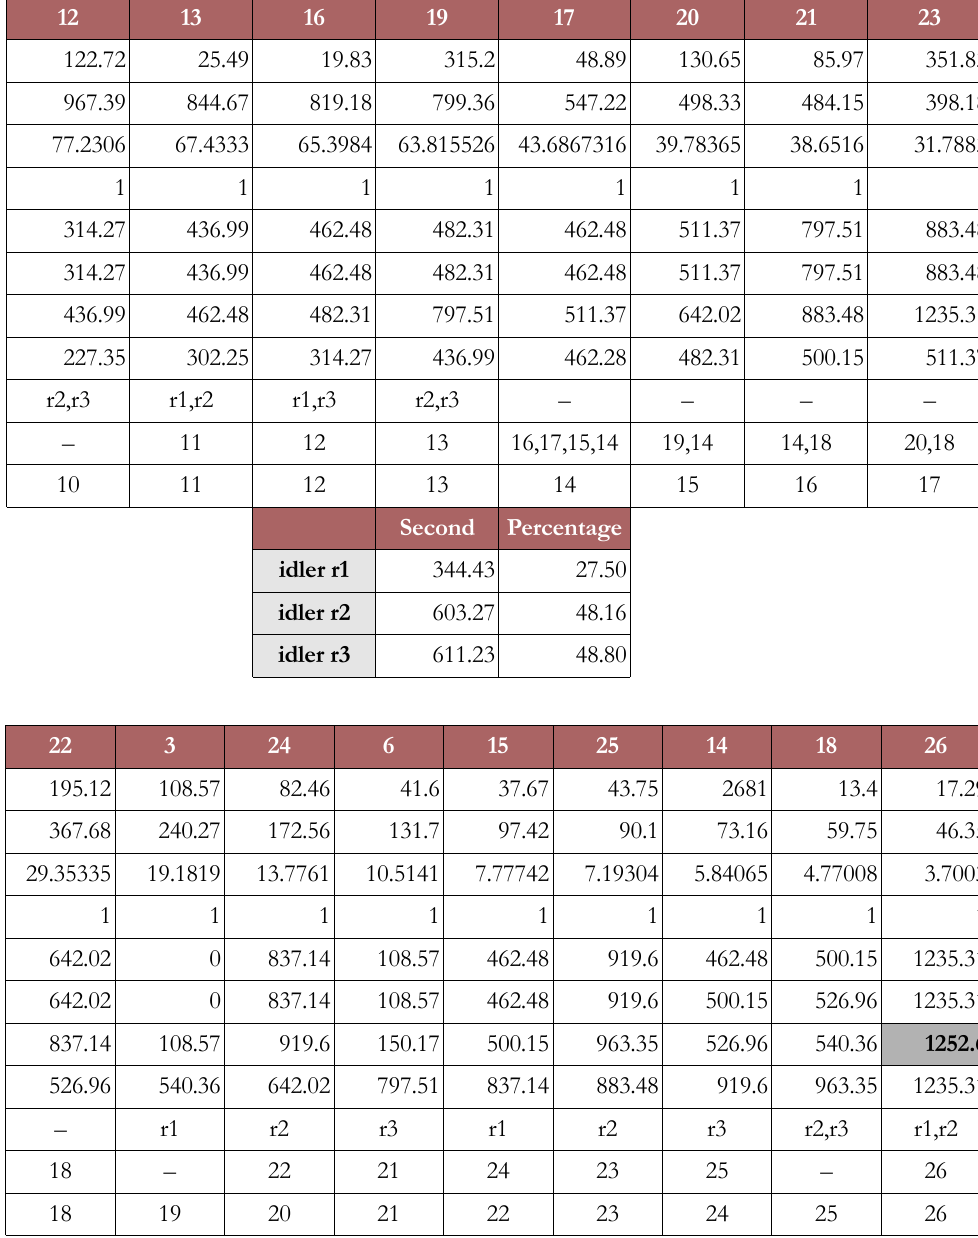
Table 6. ACTIM Scheduling, Rmax = 1, n(r) = 3 (Scenario 2)